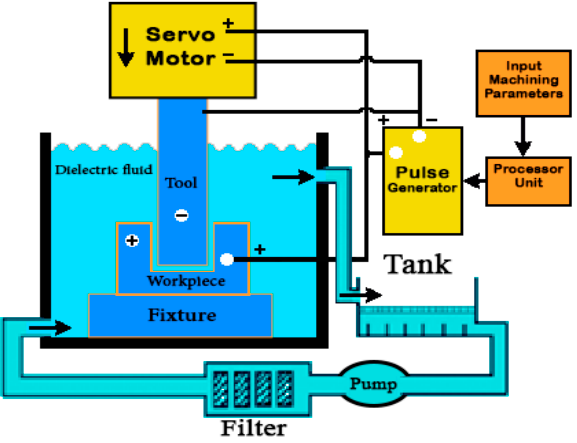
Figure 2. Schematic diagram of sinking EDM.